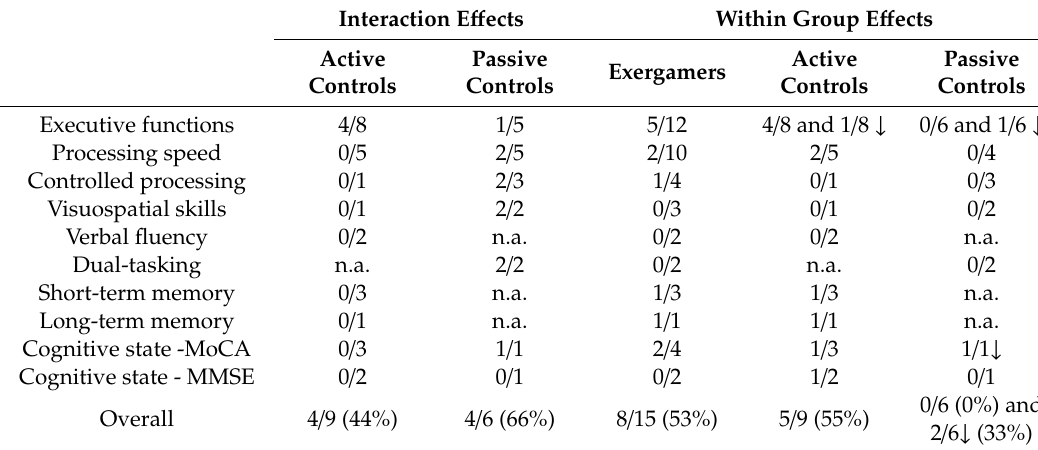
Table 2. Group by time interaction e ff ects and within group e ff ects for individual cognitive domains. First digit: number of significant findings, second digit: number of studies that assessed the respective domain, n.a. = no studies available, ↓ = lower performance at